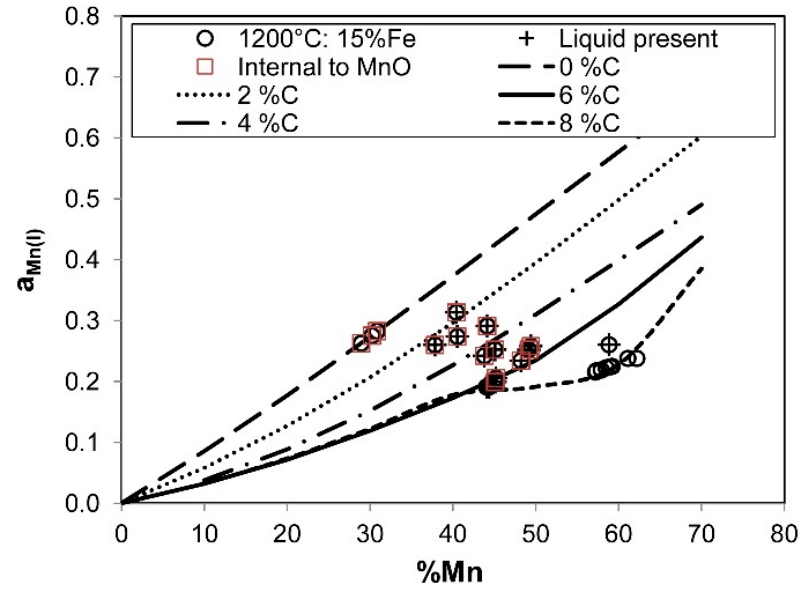
Figure 10. Mn activity vs. %Mn in Sample C (1200 °C, 15% Fe).